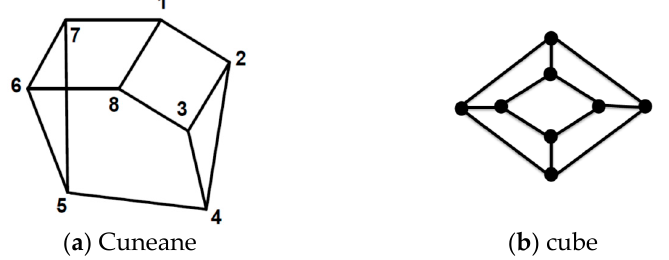
Figure 1. Illustration of two cubic graphs: ( a ) Cuneane; ( b ) cube.